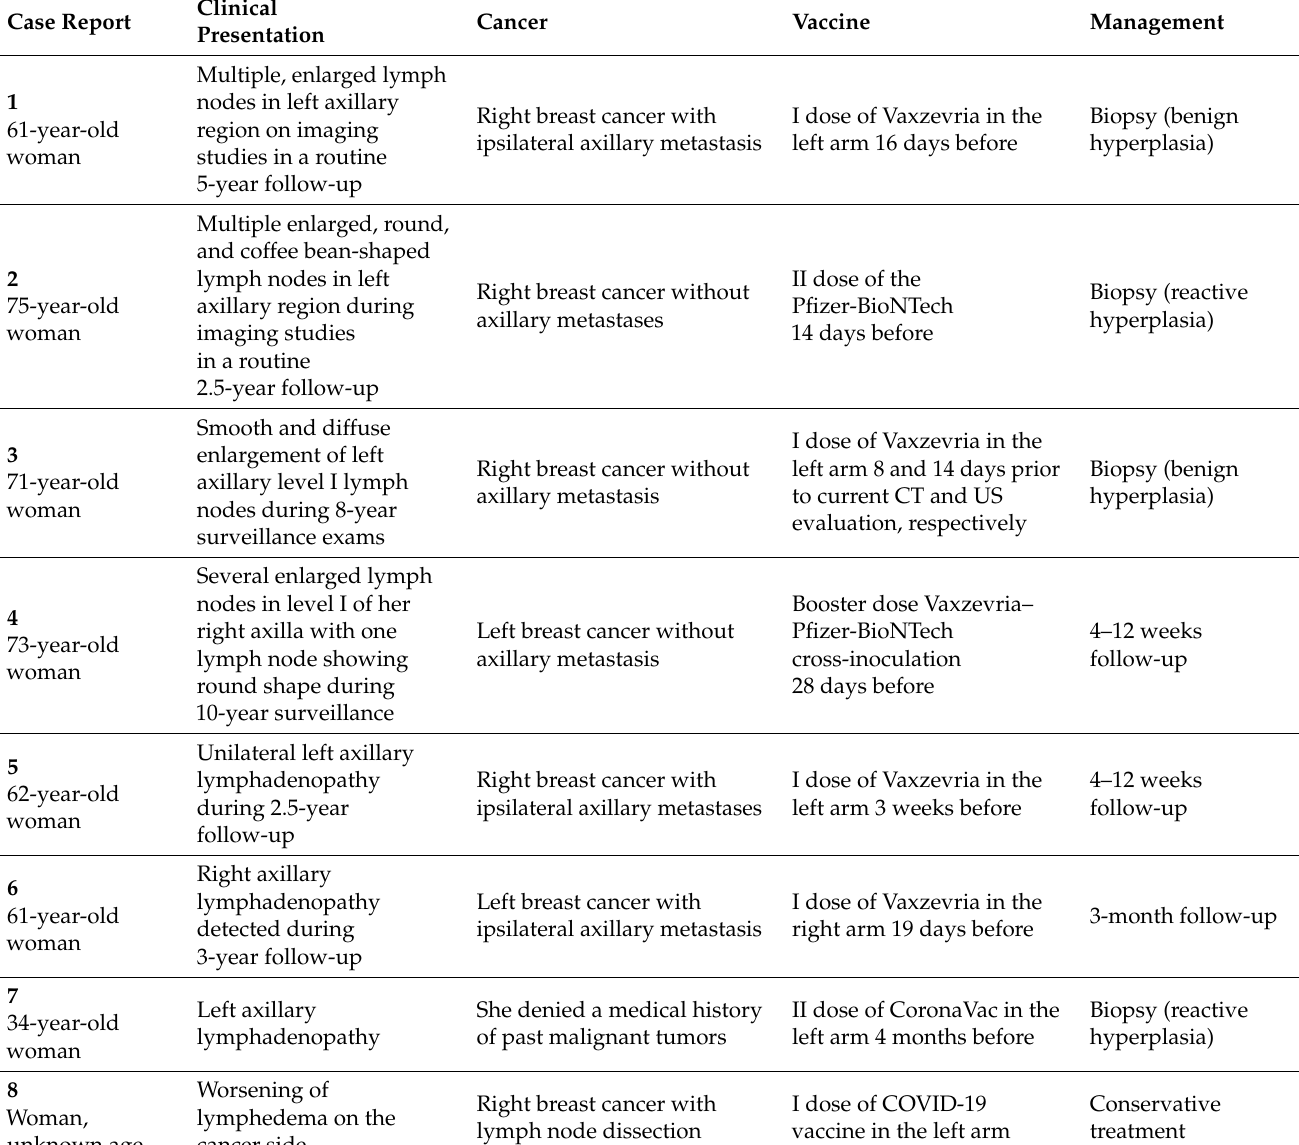
Table 1. Case reports of lymphadenopathy post COVID-19 vaccination from the